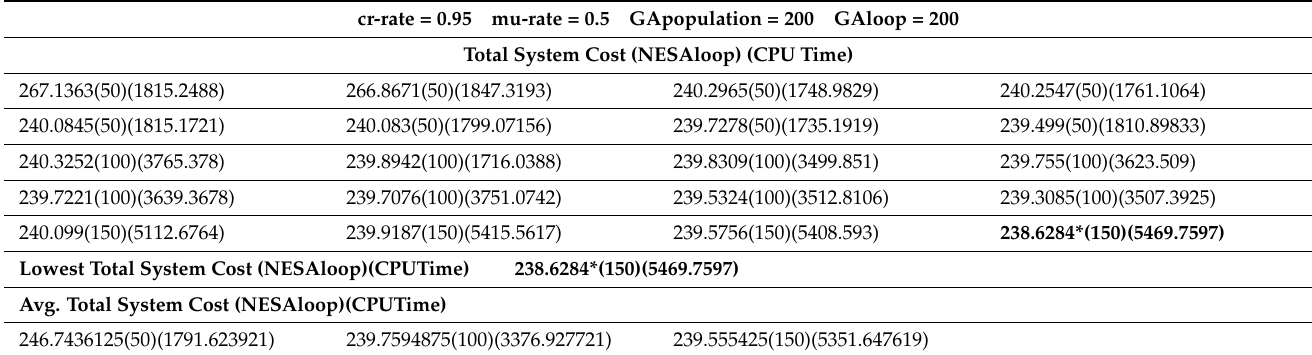
Table 31. The total system costs of 20 simulation runs obtained by NESA–MGA for the n -stage q /2 out-of- q system.